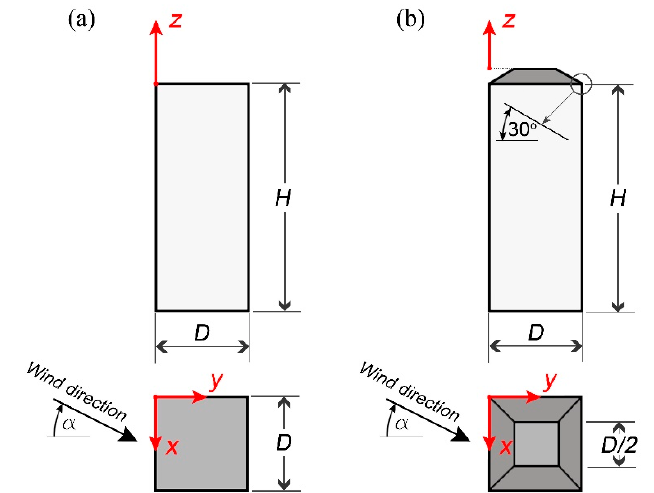
Figure 1. High-rise building model used in the investigation, ( a ) with a flat roof, ( b ) with a deck